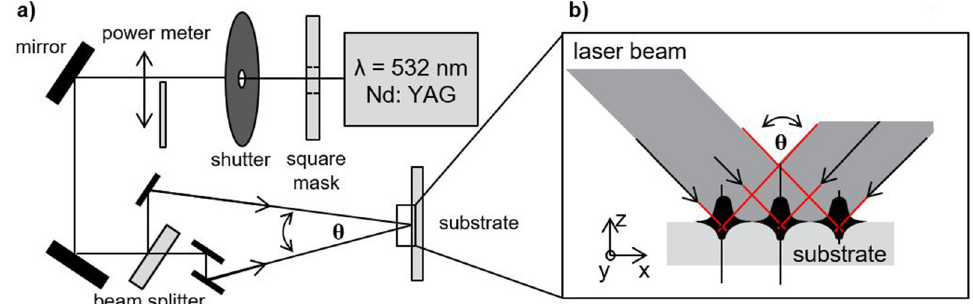
Fig. 2. (a) Schematic set-up for laser interference system and (b) resulting thermal affected surface zone according to D ’ Alessandria et al.